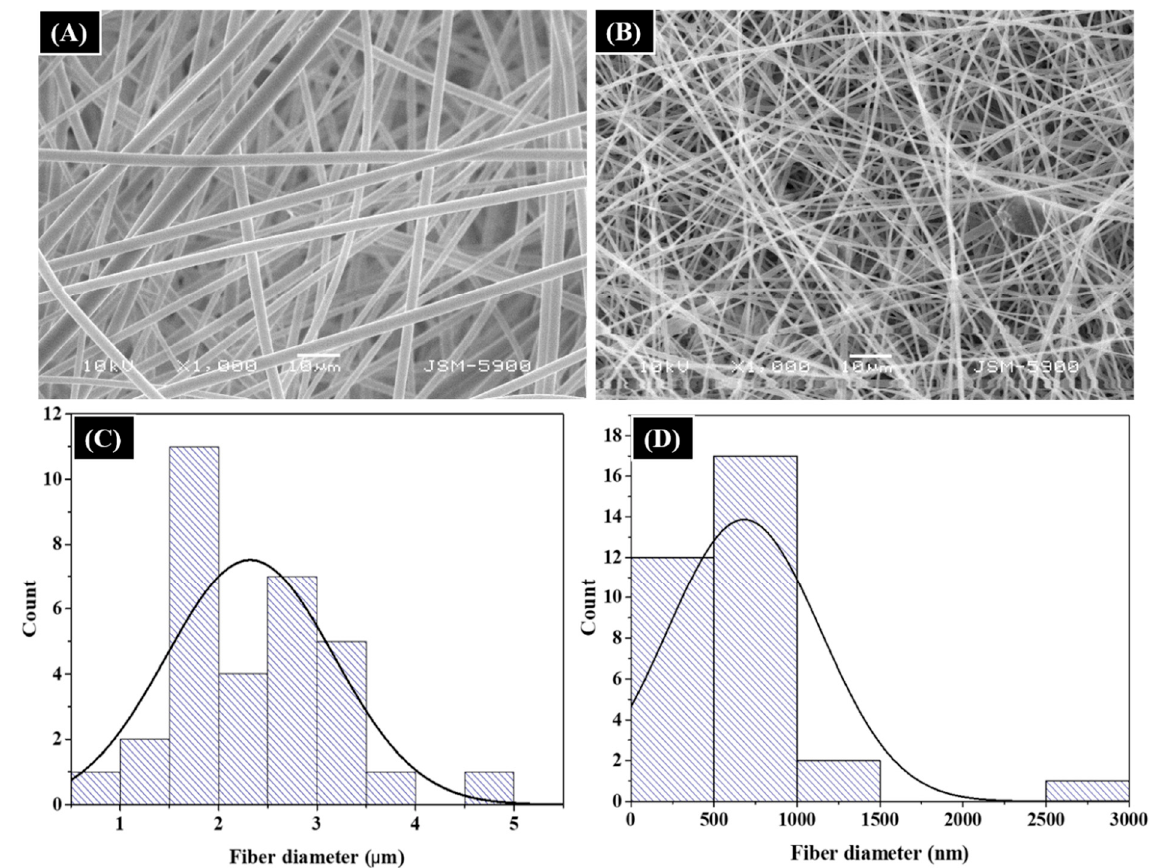
Figure 3. SEM images of as-spun pristine PS fibers ( A ) and FA/PS fibers ( B ). ( C ) and ( D ) are the diameter distribution curves of PS fibers and FA/PS fibers, respectively.